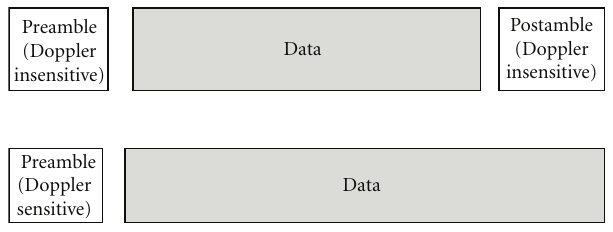
Figure 1: Top: Doppler scale estimation with Doppler-insensitive waveforms. Bottom: Doppler scale estimation with Doppler- sensitive waveforms.